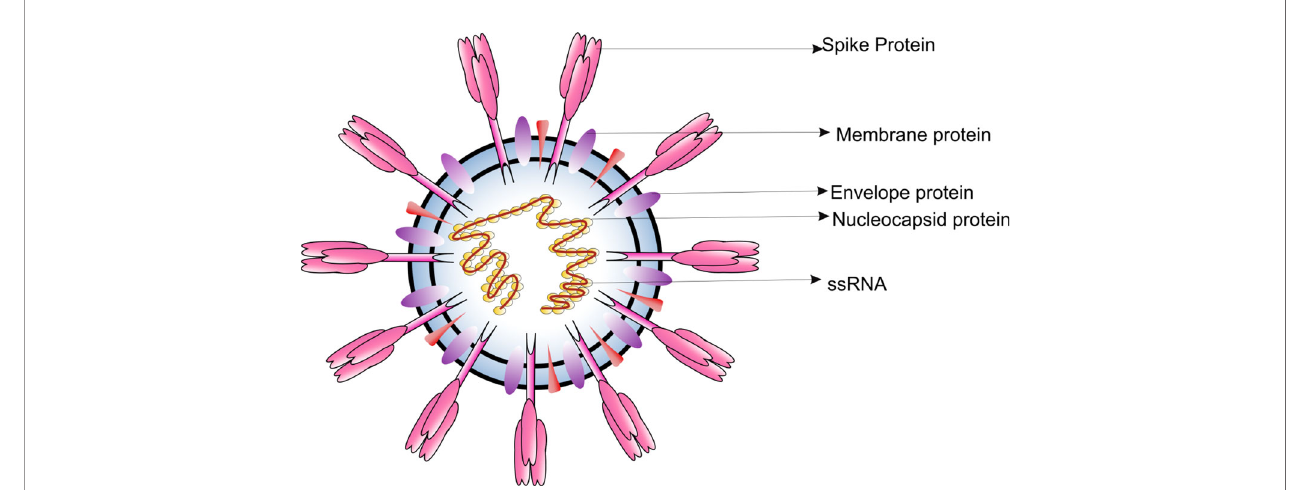
FIGURE 1 | Diagrammatic representation of the structure of respiratory syndrome causing human CoV.